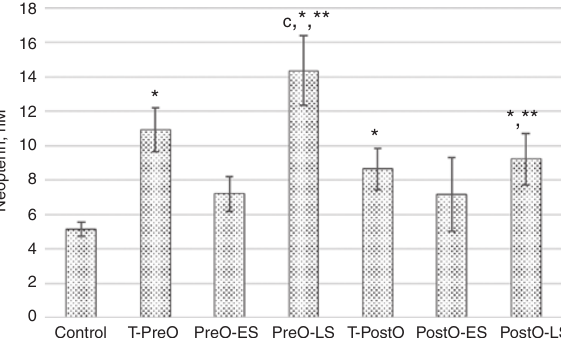
Figure 1: Alterations in the neopterin levels of the control and larynx cancer patient